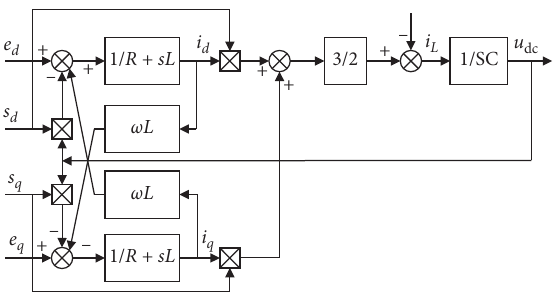
Figure 3: The model of three-phase converter in synchronous d − q frame.